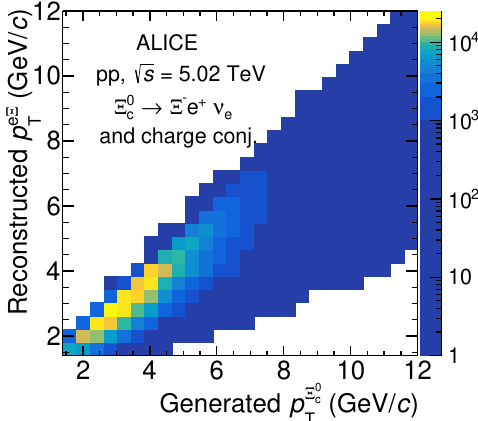
-baryon p T and the reconstructed e + Ξ − c